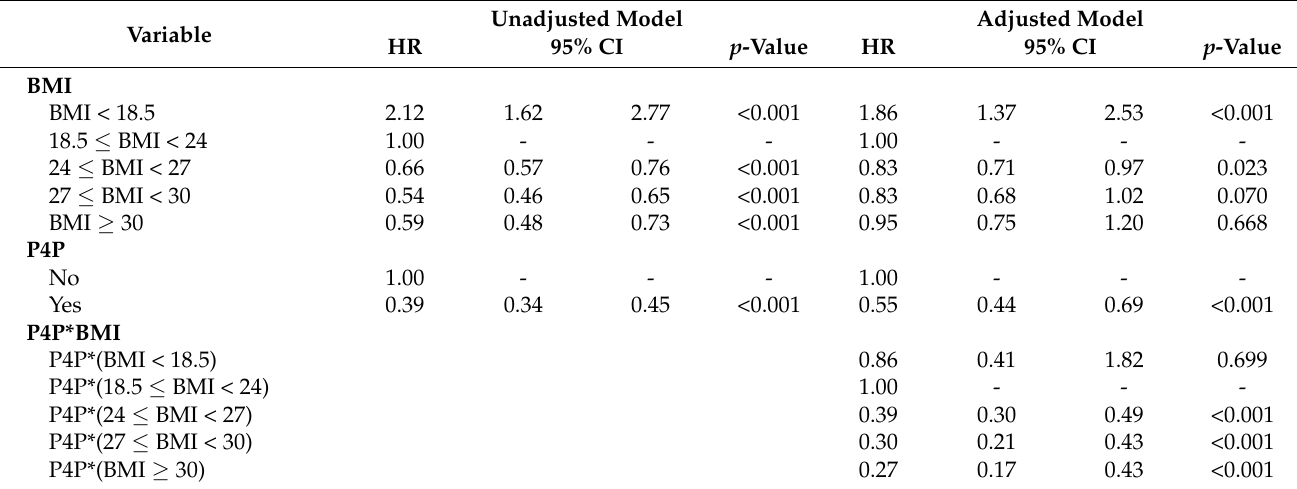
Table 4. The effects of BMI and P4P and related factors on the risk of death in patients with diabetes (results of Cox proportional hazard